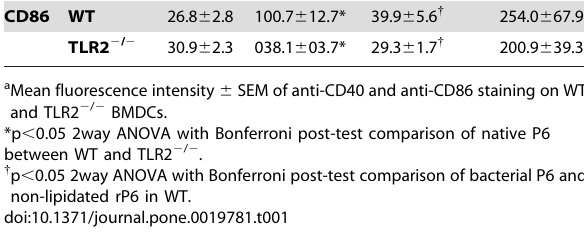
Native Non-lipidated Media P6 rP6 NTHI